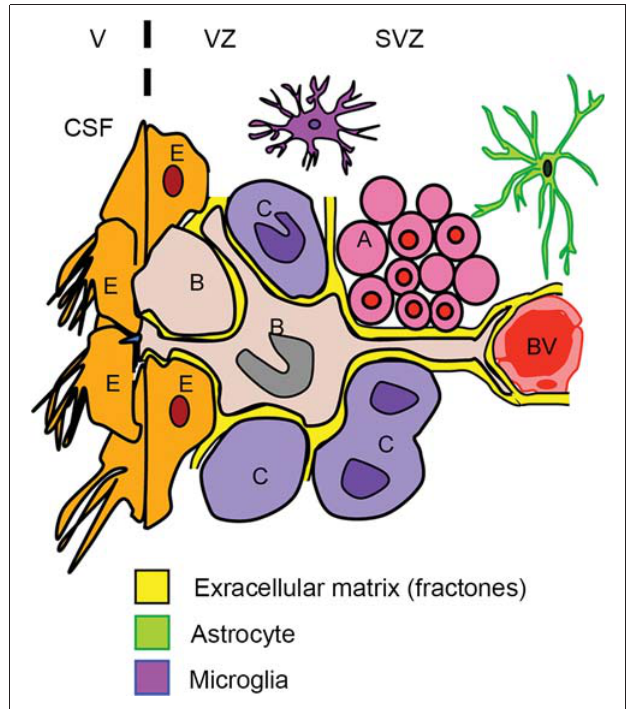
FIGURE 2 | Schematic of interplay for SVZ cells . The subventricular zone (SVZ) and ventricular zone (VZ) are lining the lateral ventricles (V) in the brain. Type B cells (B) contact the ventricle (V) containing CSF through specialized apical processes. The processes contain a single primary cilium, which is surrounded by a rosette of ependymal cells (E) with large apical surfaces forming pinwheel-like structures. On the other side, the type B cells have long basal processes with specialized endings that frequently contact BV. The type B cells also contact their progeny, i.e., type C cells (C) and the chains of migrating type A neuroblasts (A). The V-SVZ includes ECM (fractones) that contacts all the cell types including BV, microglia, and astrocytes in this